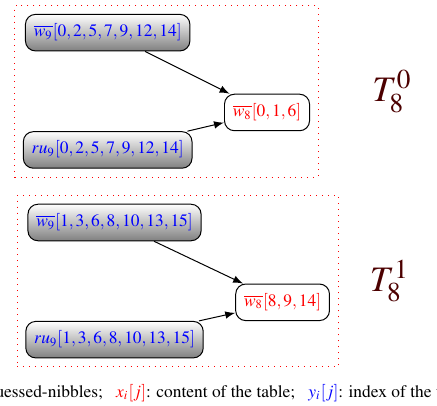
Figure 14: Constructions of Table T 0